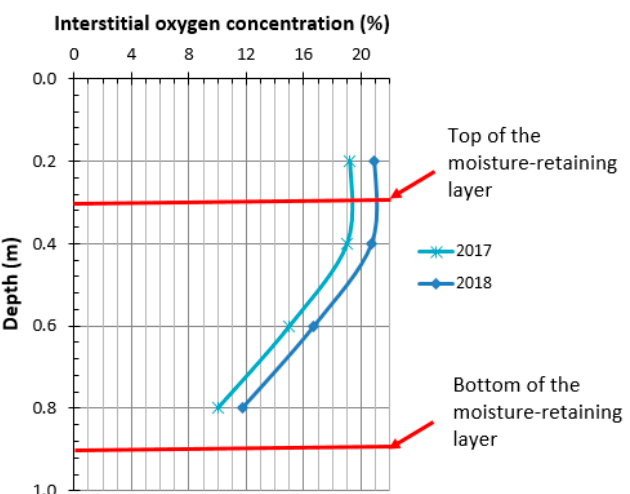
Figure 11. Interstitial oxygen concentration values obtained in the field cell (measured in August 2017 and August 2018).